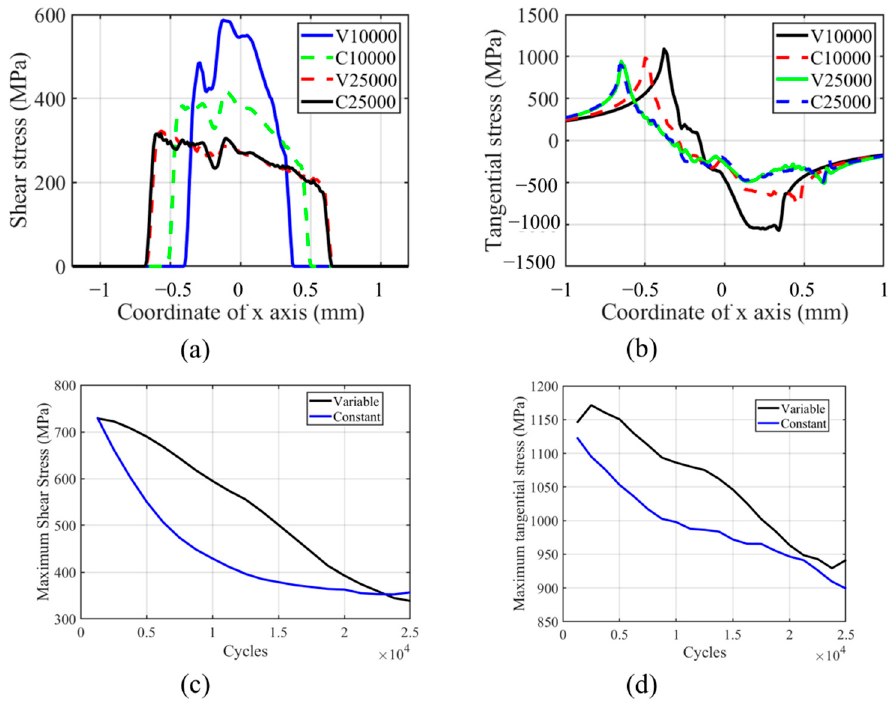
Figure 18. Profile and history of shear and tangential stresses for the flat specimen in the gross sliding regime for both CWCM and VWCM: ( a , b ) are shear and tangential stress profiles in 10,000th cycle and 250,000th cycle when δ = 50 mm, and ( c , d ) are the history of maximum shear and tangential stress, respectively.